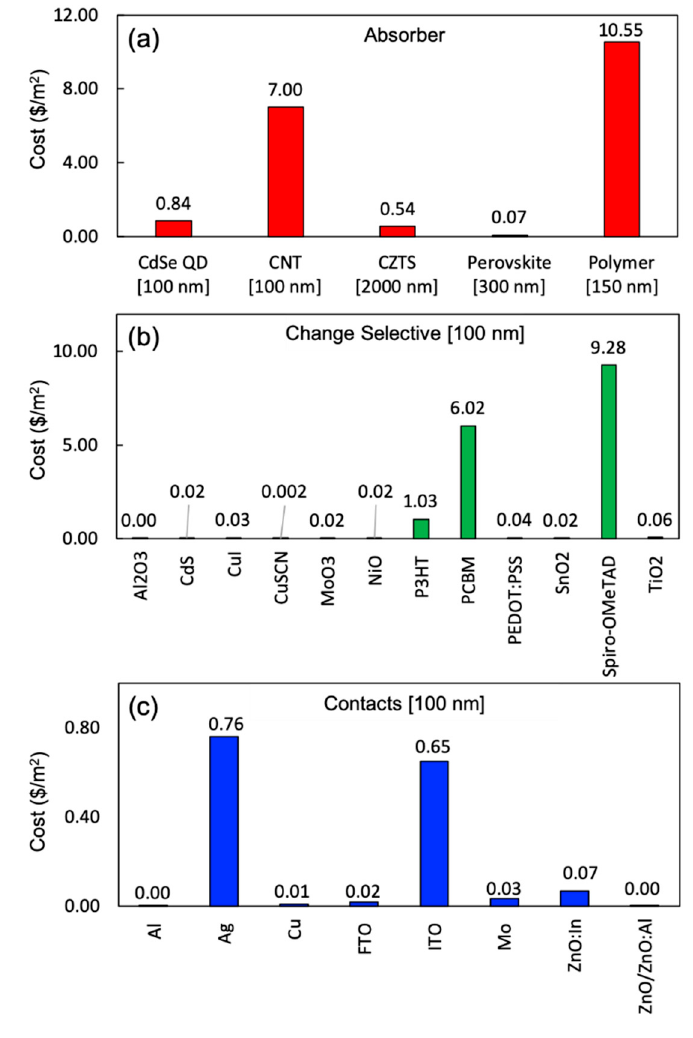
Figure 3. Material cost of the different layers used as absorber ( a ), charge selective ( b ) and contact ( c ) materials.